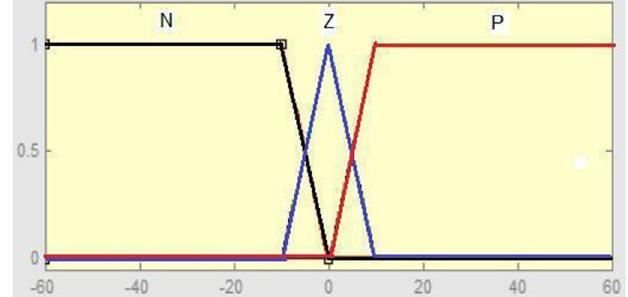
Fig. 11. Power variation membership function.